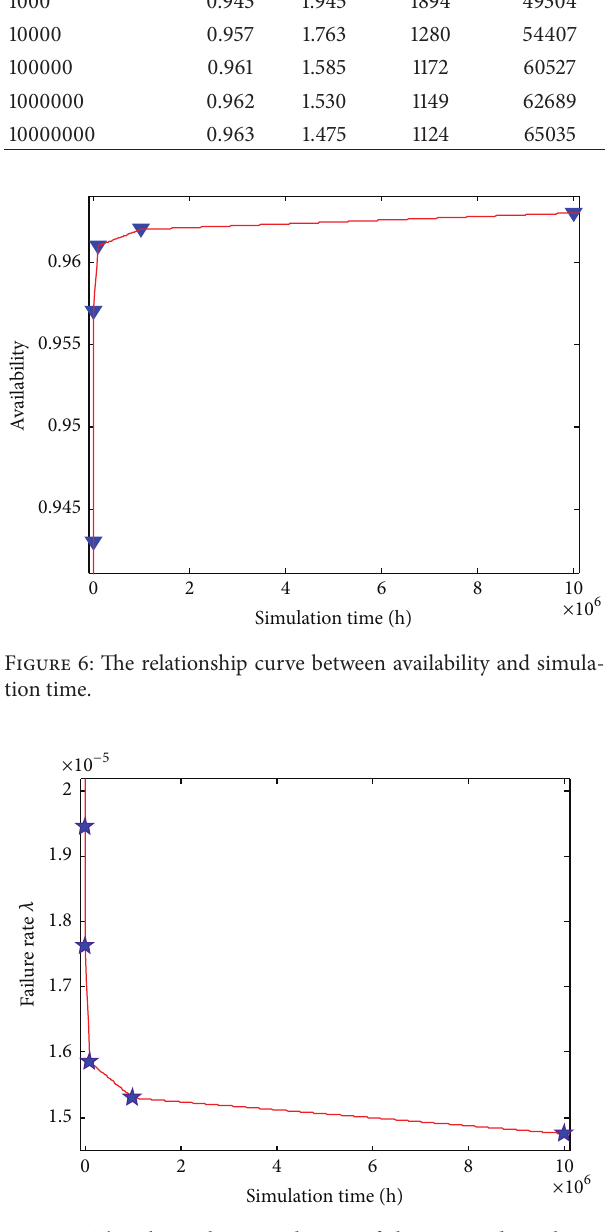
Figure7:Therelationshipcurvebetweenfailurerateandsimulation time.